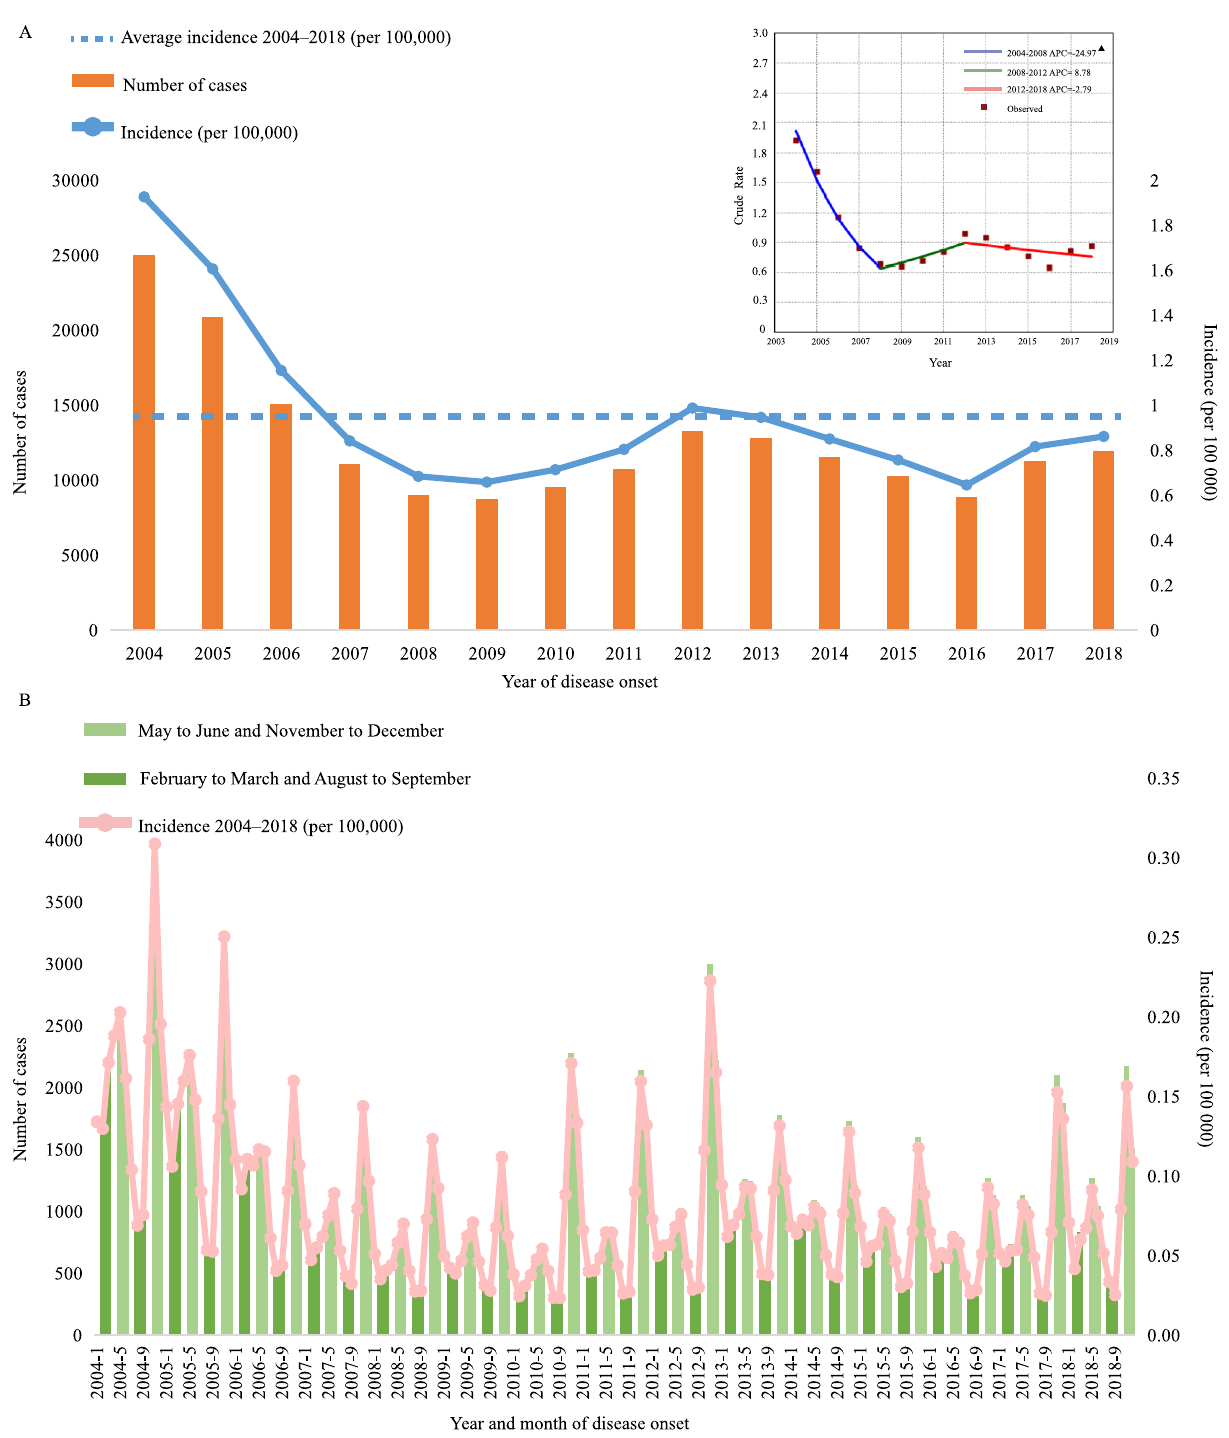
Figure 1. The incidence and number of HFRS cases reported in China, 2004–2018. ( A ) Number of cases and incidence by year. Trend of the incidence rate of HFRS between 2004 and 2018 shown by the joinpoint regression (upper right corner). The red squares represent the observed crude incidence of HFRS and the lines represent the slope of the annual percentage change (APC). ( B ) The pink line represents the monthly incidence of HFRS. The bar chart shows the number of cases at peak and